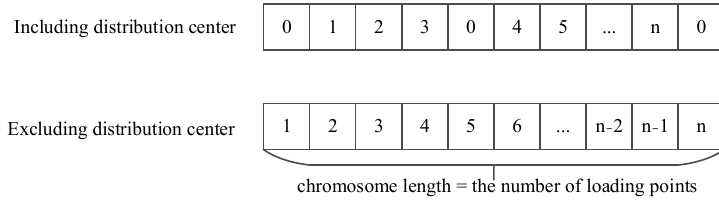
Figure 4. Sequence coding of chromosome.